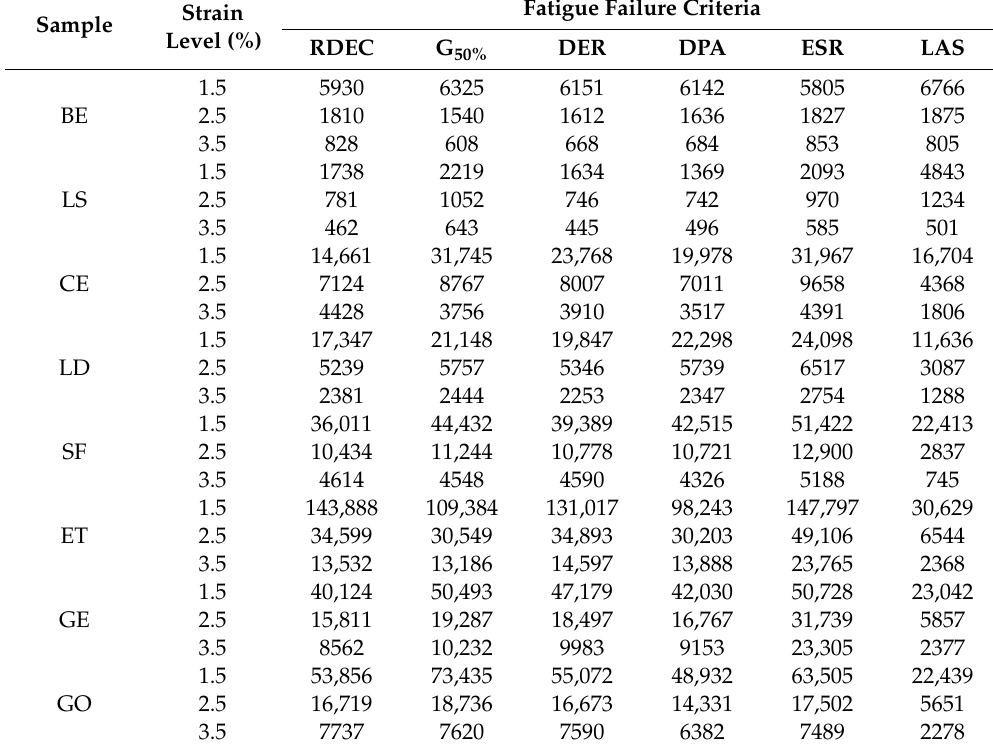
Table 2. The fatigue life of di ff erent mastics determined with di ff erent